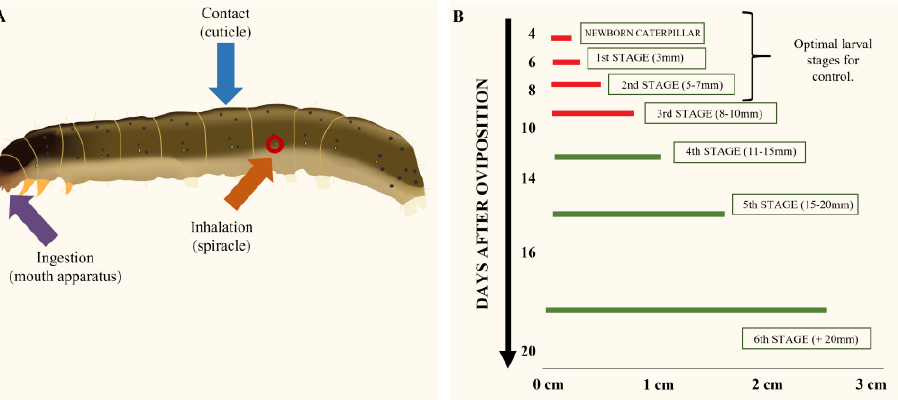
Figure 2. ( A ) Routes of entry of EOs to lepidopteran larvae. Orange arrow: entry through the respiratory spiracles. Purple arrow: entry through ingestion of treated food. Blue arrow: entry by direct contact with the integument. ( B ) Optimal moments of chemical control thought the larval stages of S. frugiperda. Red segments indicate the optimal stage for chemical control. (Modified from Programa Manejo de Resistencia de Insectos (MRI) and the Insecticide Resistance Action Committee (IRAC Argentina) [55].)